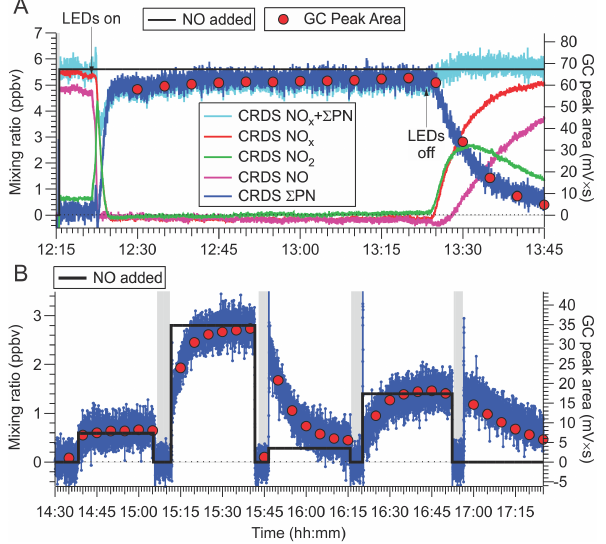
Figure 3. (a) Example of photochemical conversion of NO to PPN. Time series of NO (magenta), NO 2 (green), (cid:54) PN (blue), NO x (red), and NO x + (cid:54) PN (turquoise) mixing ratios observed by TD-CRDS (1s data presented) and of HP PAN-GC peak area (red circles) when the photochemical source was operated with DIEK to generate PPN. The black line is the NO mixing ratio (left axis) added to the UV- LED photo source, calculated from gas cylinder concentration and flow rates. An offset of 2.0ppbv arising from DIEK was subtracted from the NO 2 and NO x data prior to presentation. (b) Time series in which the amount of NO added was systematically varied as in- dicated by the black